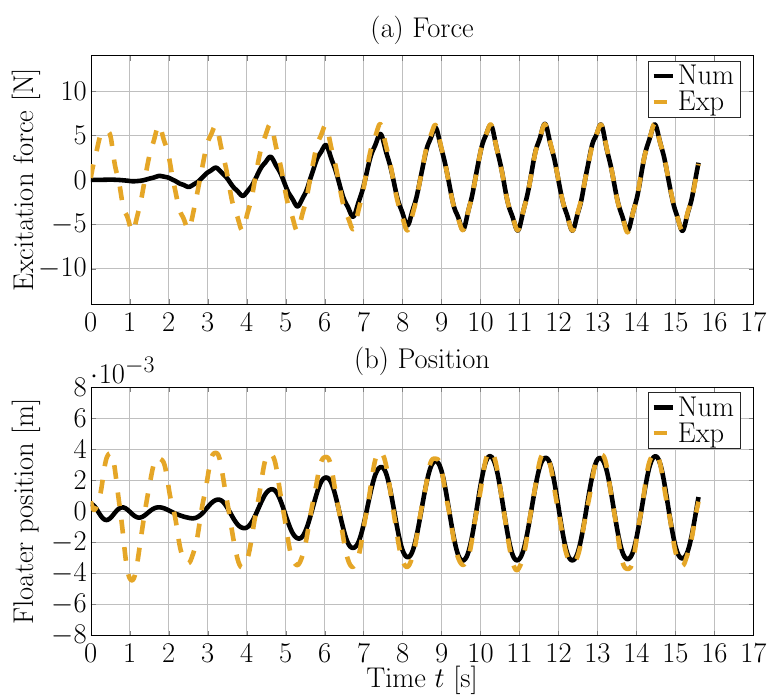
Figure 17. Time trace of the single-frequency (0.71 Hz) excitation force ( a ) and the floater position ( b ).